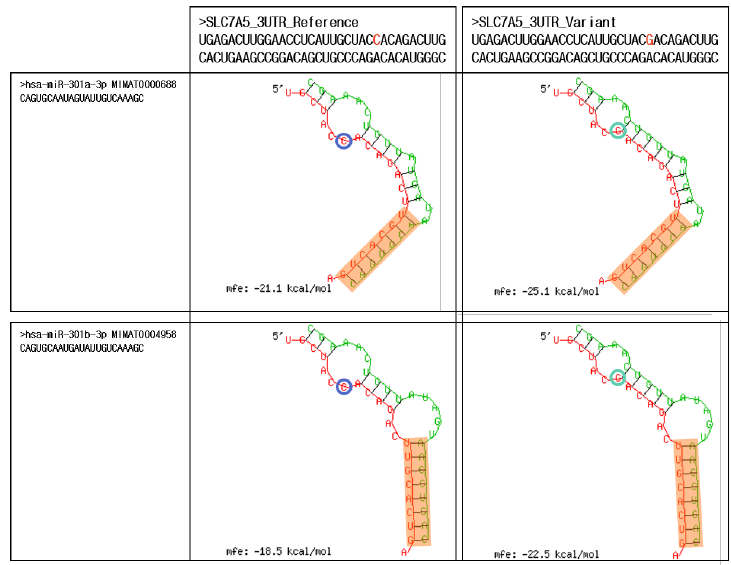
Figure 2. Duplexes identified by in silico analysis between a microRNA (miR) and rs1060253 of the SLC7A5 (left: reference allele; right: variant allele) for hsa-miR-301a-3p (top) and miR-301b-3p (bottom). The shades denote the seed region of miR-301a-3p and -301b-3p. The circles represent the reference and variant nucleotides of rs1060253 .